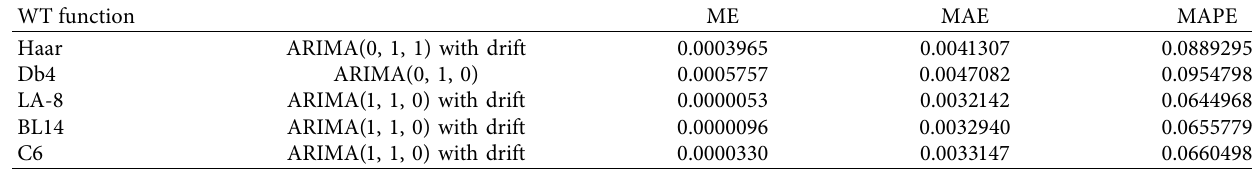
Table 5: The WT function of output variable for 80%